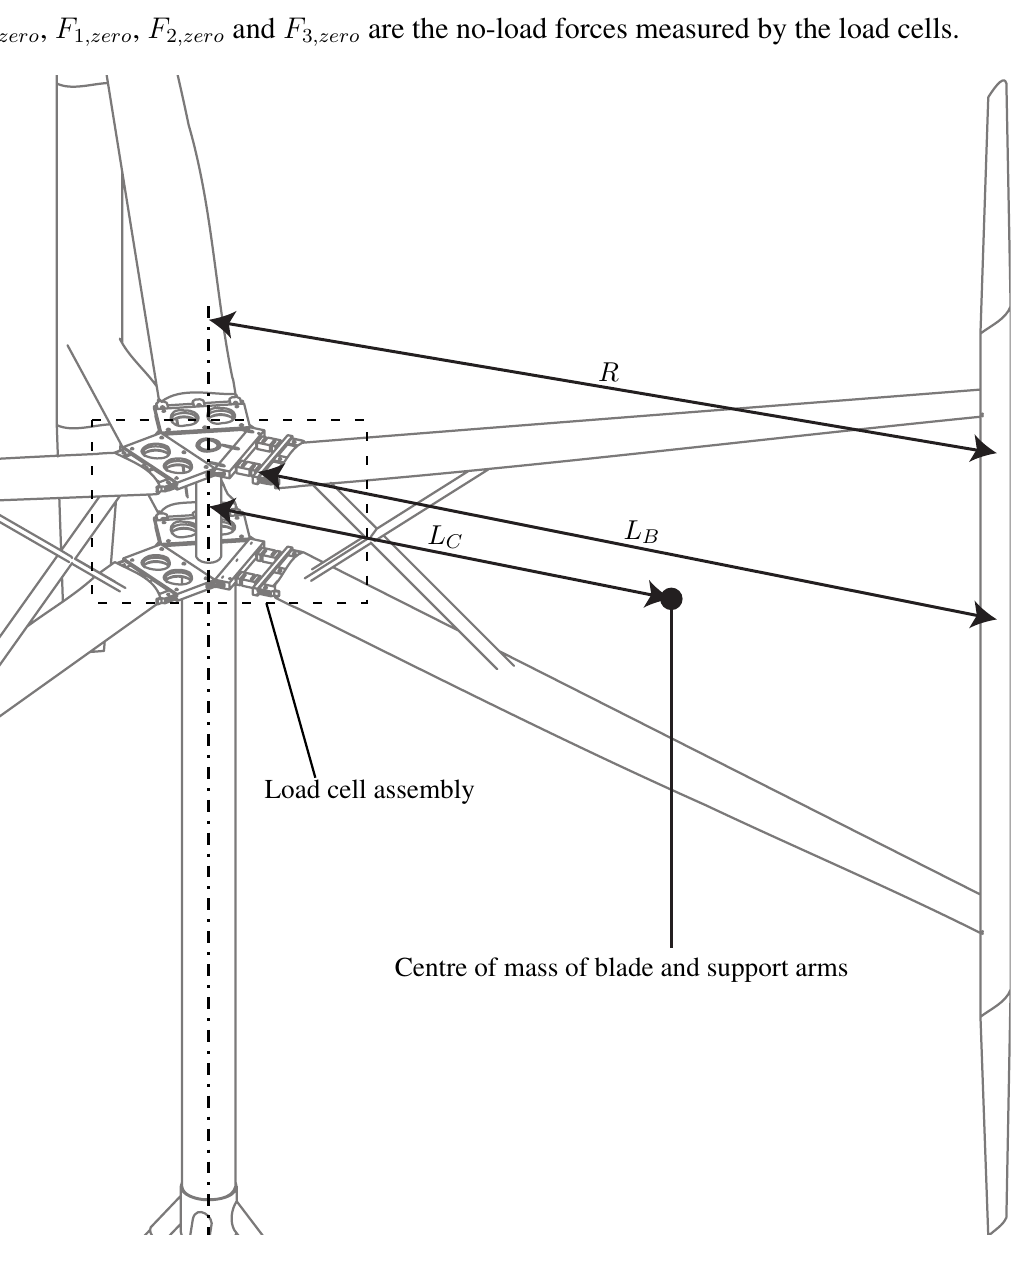
Figure 2. Load cell setup on the